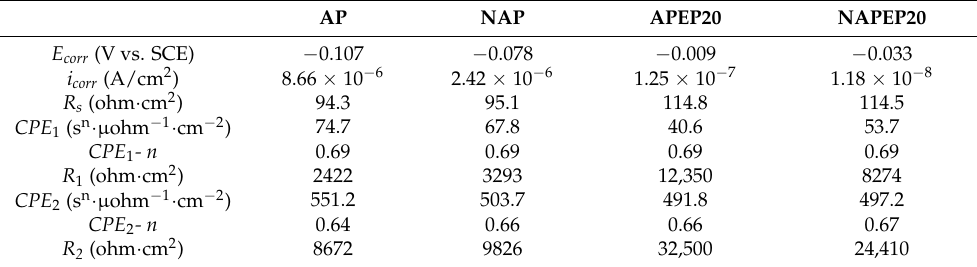
Table 2. Corrosion parameters and impedance for the NAP, AP, NAPEP20 and APEP20 samples in 3.5 wt.% NaCl